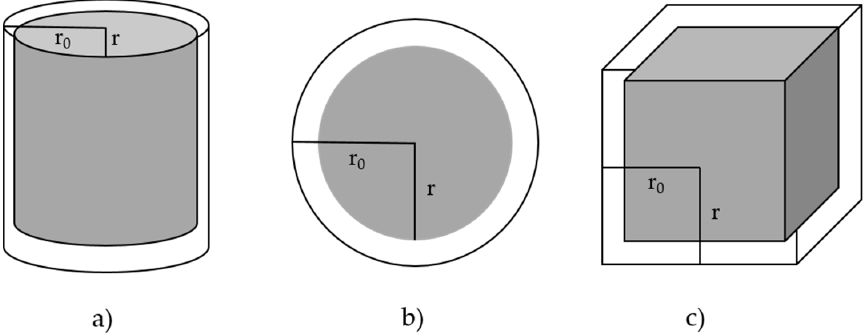
Figure 5. Geometric models, where r is the radius at time t and r 0 is the radius at time t 0 : ( a ) cylinder (R2); ( b ) sphere (R3); ( c ) cube (R3).